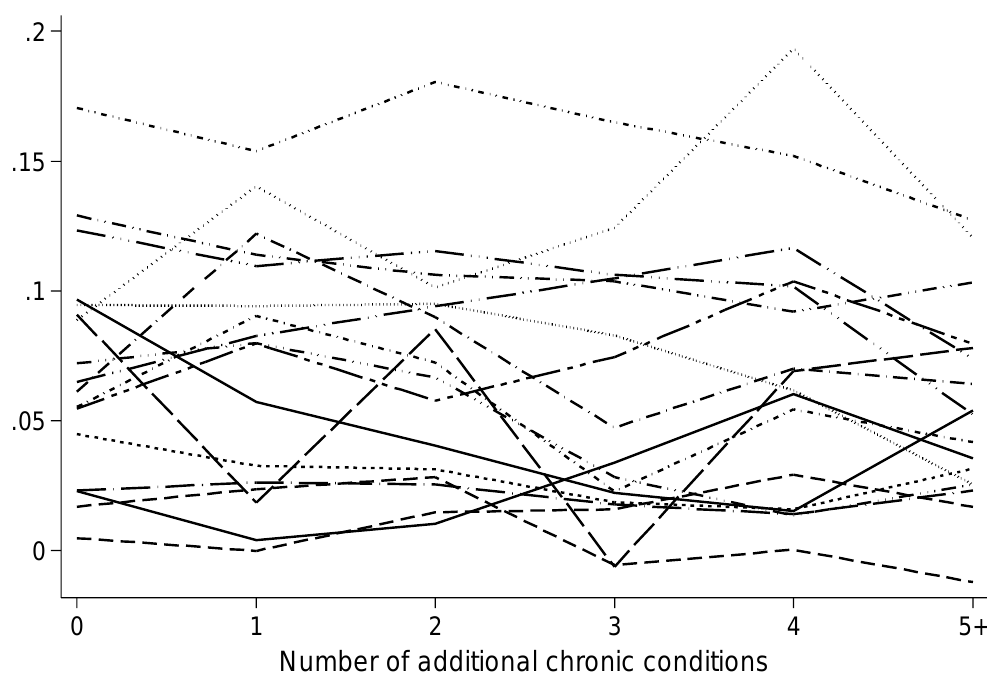
Figure 2: Mean decrement in EQ-5D-3L index score by number of additional chronic conditions for 17 common chronic